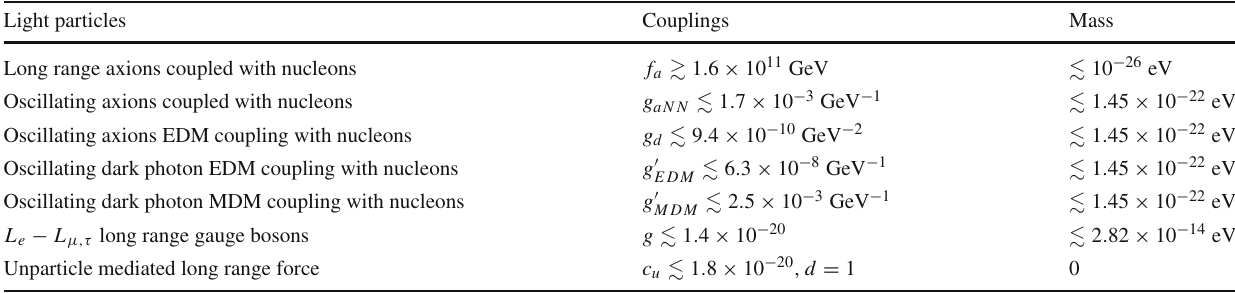
Table 1 Summary of bounds on spin-dependent and spin-independent couplings and masses of light particles from geodetic and frame dragging measurements Light particles Couplings Mass Long range axions coupled with nucleons Oscillating axions coupled with nucleons Oscillating axions EDM coupling with nucleons Oscillating dark photon EDM coupling with nucleons Oscillating dark photon MDM coupling with